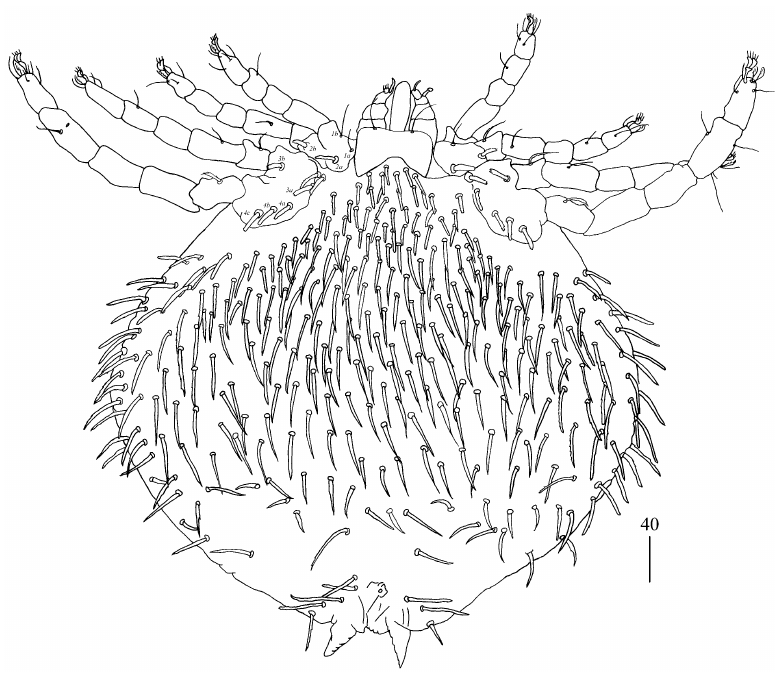
Figure 7. Geckobia mysoriensis sp. n. female in ventral view.